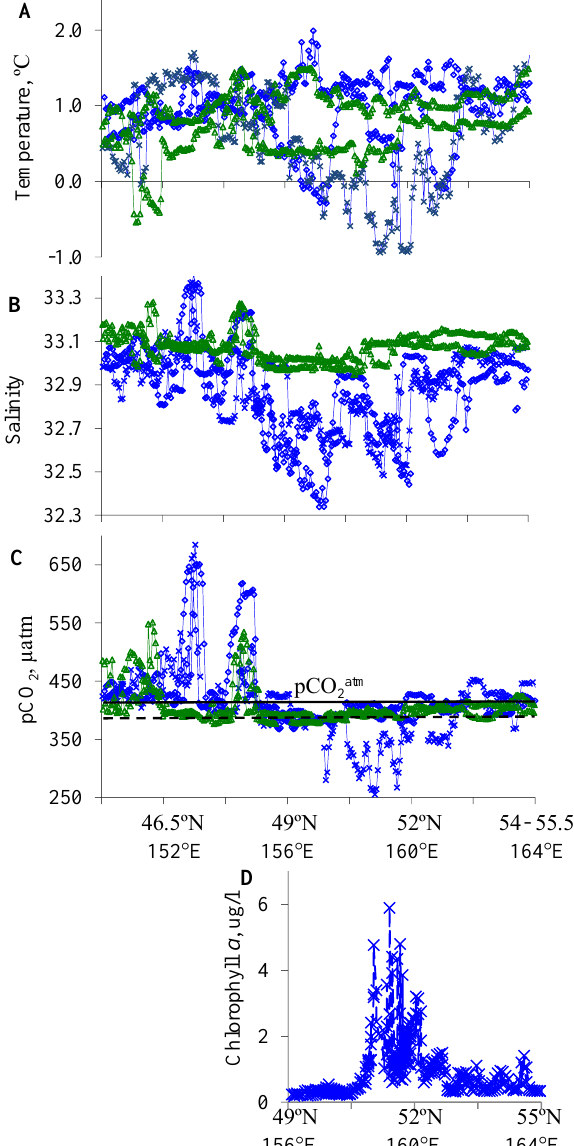
Figure 4. The temperature ( A ), salinity ( B ), pCO 2 ( C ), and chlorophyll a ( D ) distribution in the EKC zone in winter 2003 and winter–spring 2013 (green triangles—31.01—02.02.2003, 06—07.03.2003; blue diamonds—16—18.01.2013, 16—18.02.2013; blue crosses—19—21.04. 2013). The dotted and solid red lines in Figure 3c show the pCO 2 atm in January—March 2003 and January—April 2013, respectively.